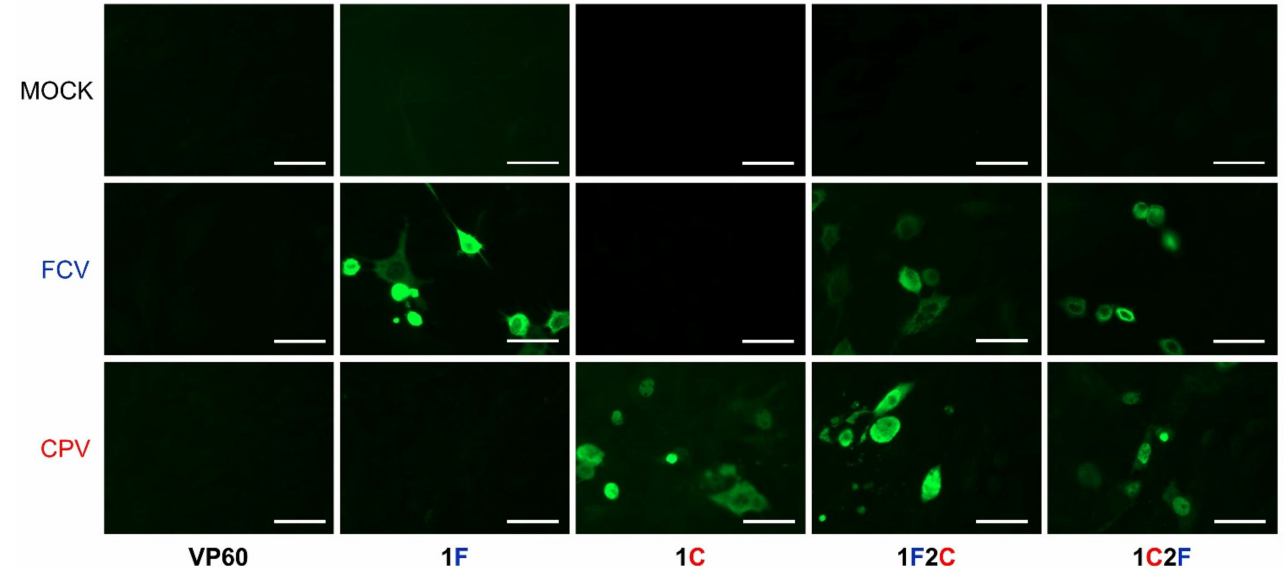
Figure 6. Analysis of sera reactivity with FCV and CPV viruses by immunofluorescence. Indirect immunofluorescence assays were performed using non-infected (mock), FCV-infected (FCV), or CPV-infected (CPV) monolayers of CRFK cells with sera samples of the indicated mice groups. Scale bars = 50 µ